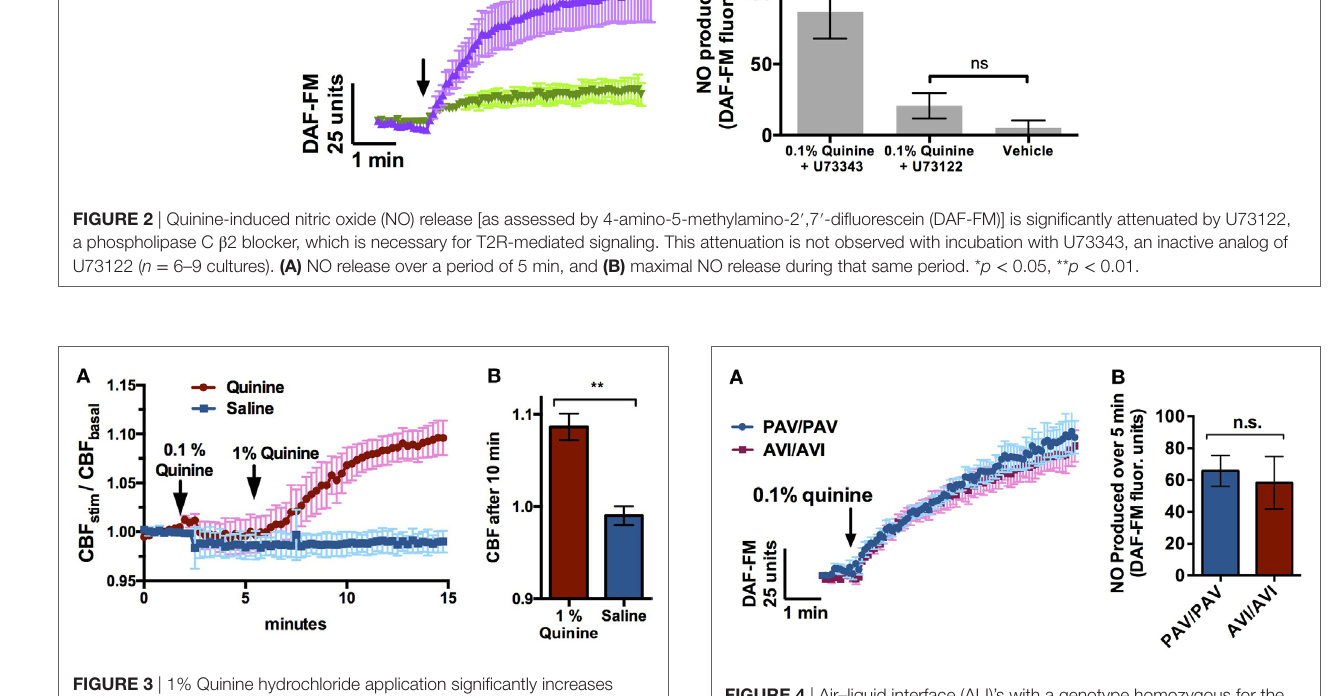
FigUre 4 | Air–liquid interface (ALI)’s with a genotype homozygous for the functional form of the T2R38 receptor (PAV/PAV) or a genotype homozygous for the non-functional form of the receptor (AVI/AVI) demonstrated no significant differences in 4-amino-5-methylamino-2 ′ ,7 ′ -difluorescein (DAF-FM) fluorescence intensity in response to 0.1% quinine over a period of 7 min ( n = 6 cultures per condition). (a) Nitric oxide (NO) release over a period of 5 min, and (B) maximal NO release during that same